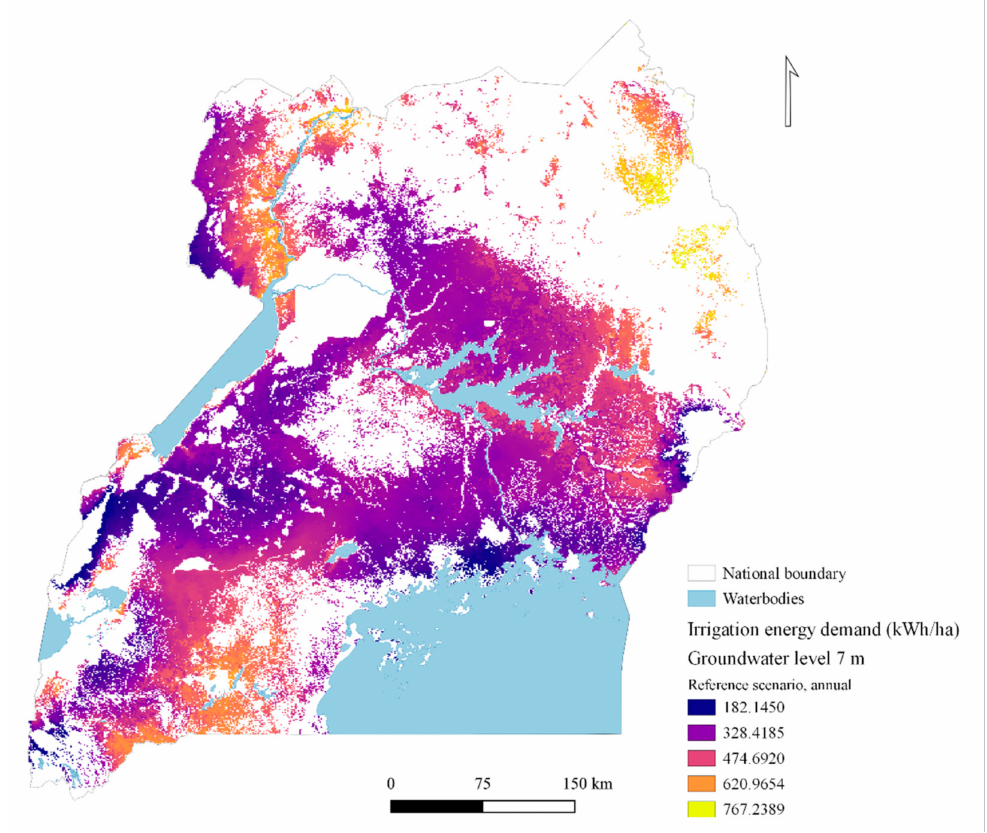
Figure 8. Annualenergydemanddistribution(MWh/ha)forirrigationwaterpumping,